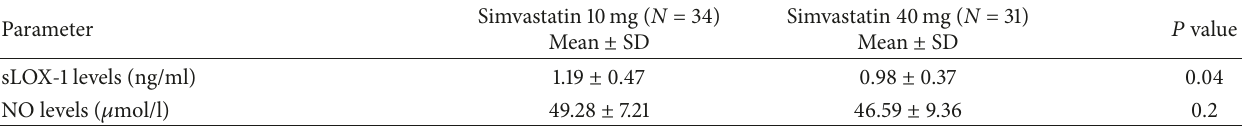
Table 3: Serum sLOX-1 and NO levels in patient with acute ischemic stroke received simvastatin therapy for 90 days.